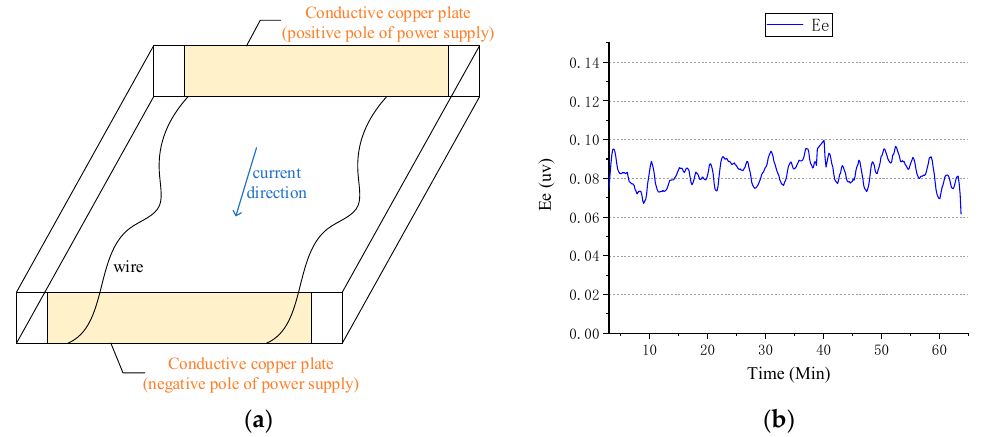
Figure 5. Laboratory background noise environment construction and test result analysis chart: ( a ) schematic of the background noise test. Conductive copper plate: construction of simulated ocean current electric field environment. Wire: connects two conductive copper plates. ( b ) Background noise test result plot: variation in background noise level over time in simulated environment.